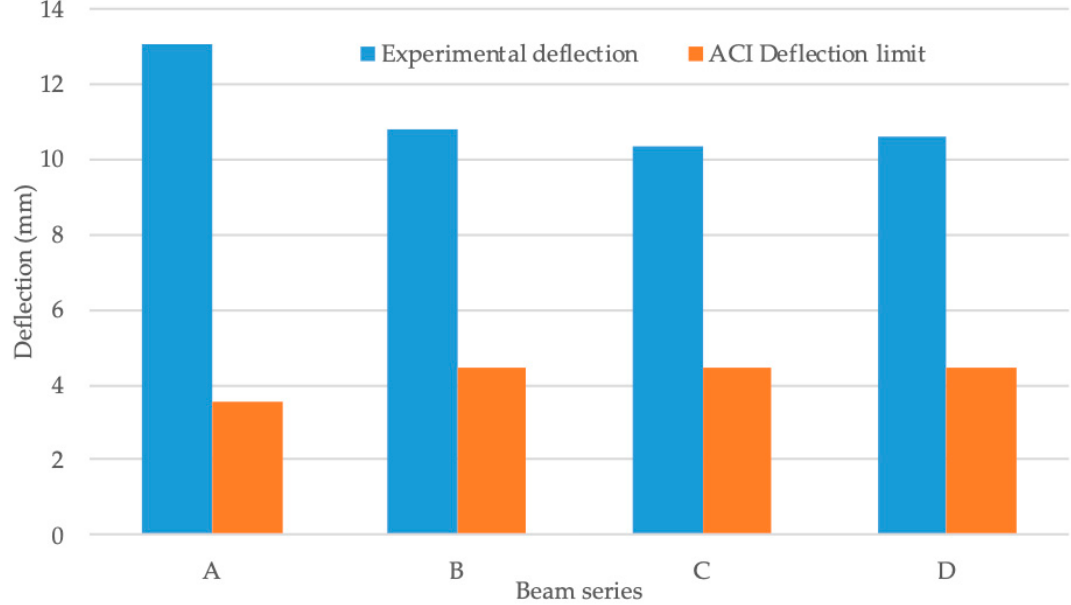
Figure 20. Maximum deflection limits comparison between ACI standard and experiments.